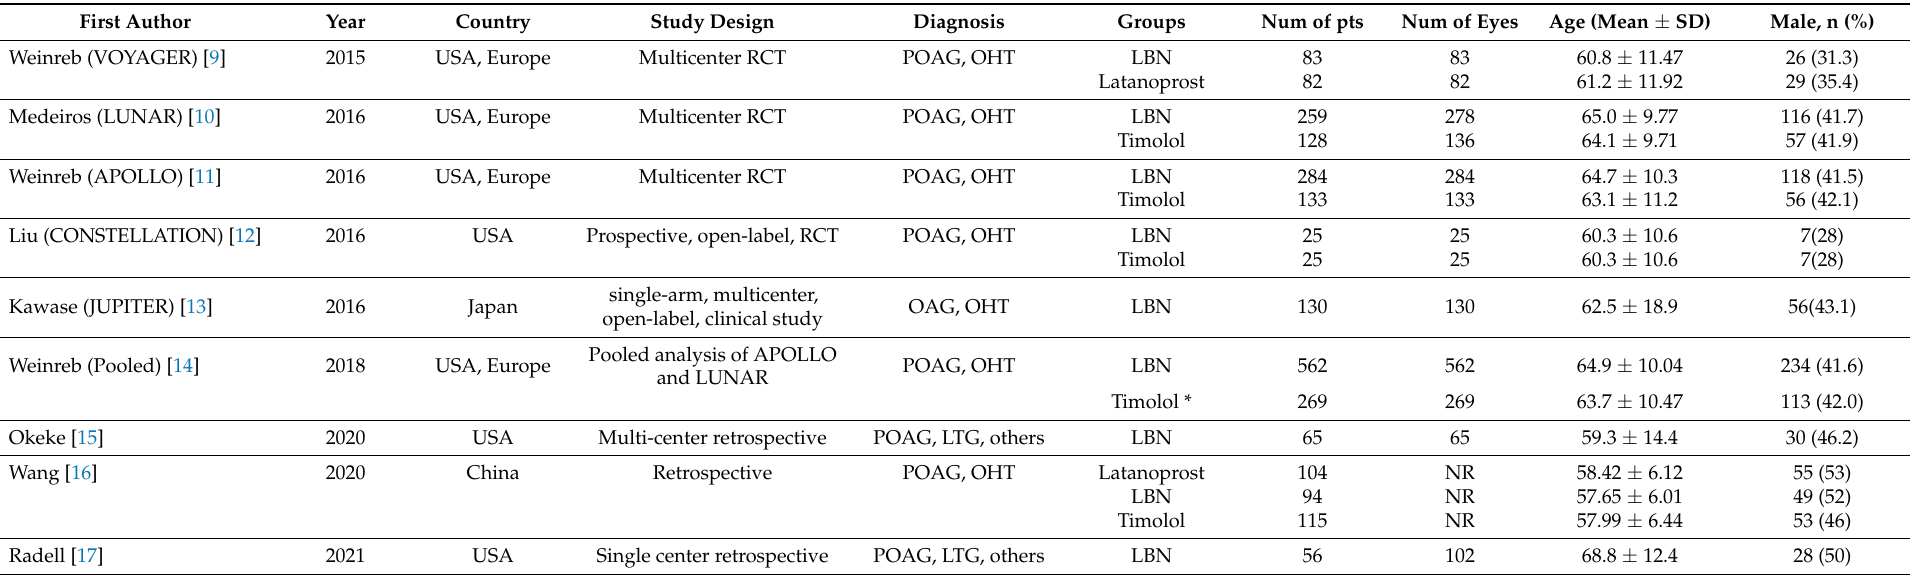
Table 1. Demographic characteritics of patients in studies included in